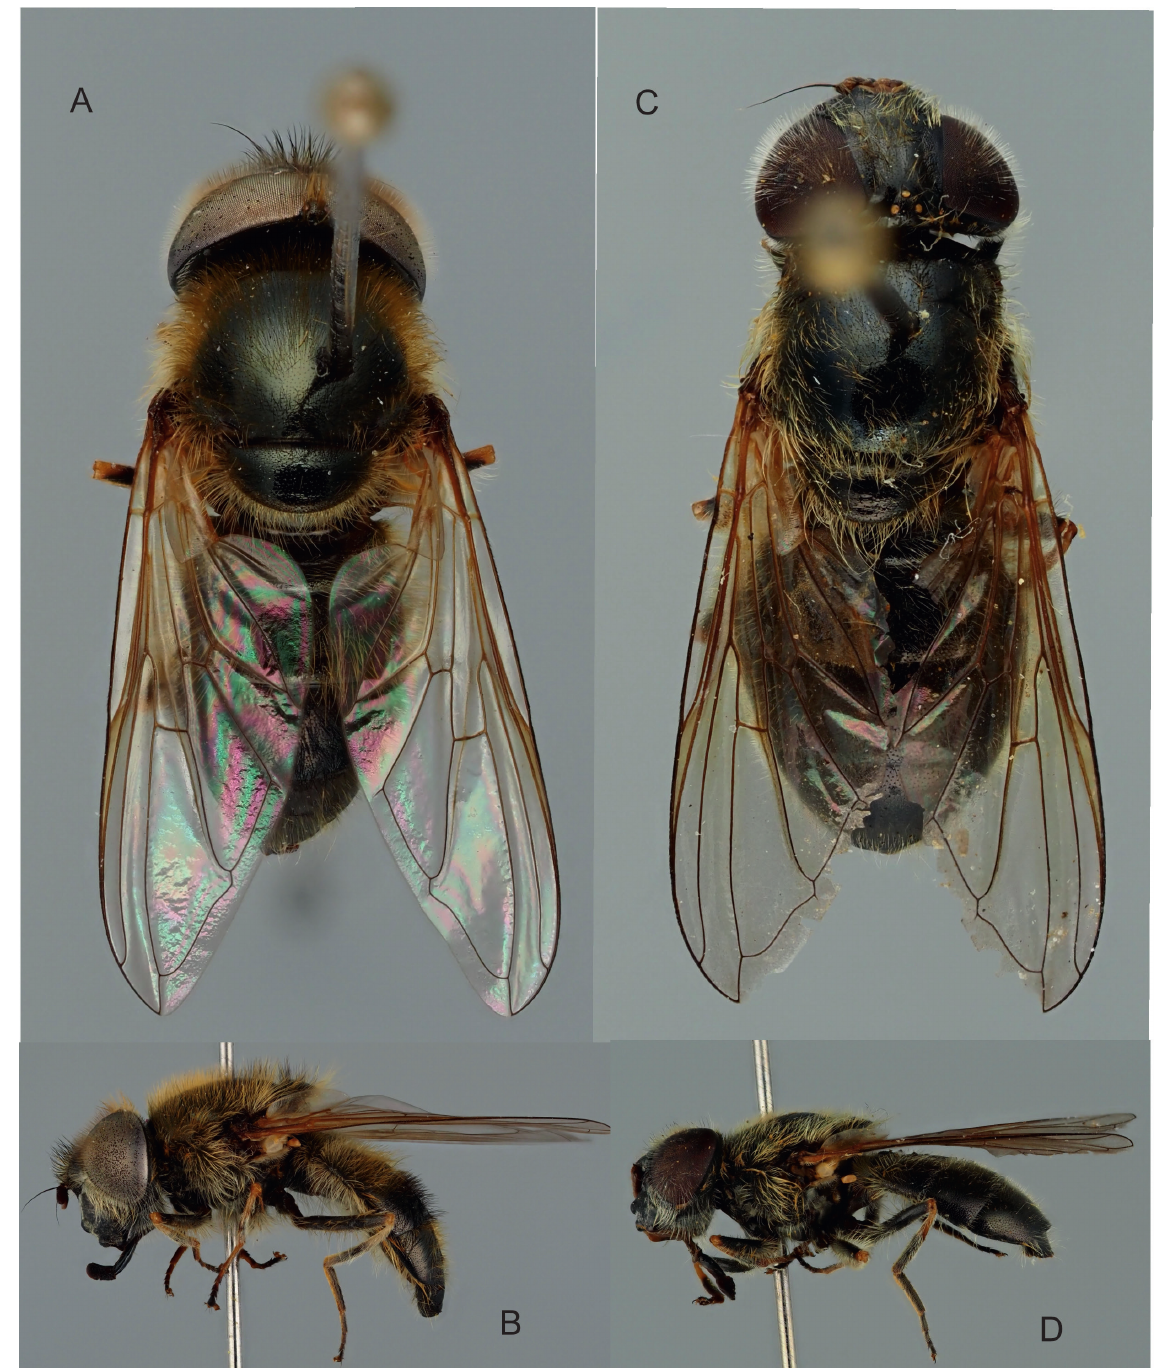
Fig. 16. Cheilosia ( Montanocheila ) distincta Barkalov & Cheng, 1998. A–B . ♂ (CSCA); dorsal and lateral views. C . ♀ (IBSJW/NME); dorsal and lateral view. Not to